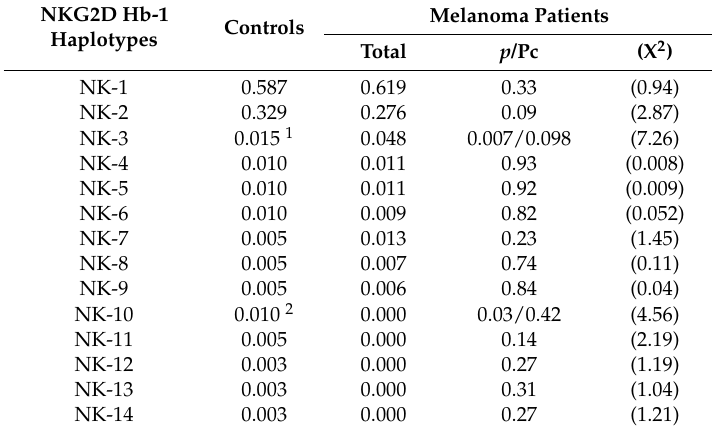
Table 4. NKG2D Hb-1 haplotype frequency in healthy controls and melanoma patients. NKG2D Hb-1 Controls Melanoma Patients Haplotypes Total p